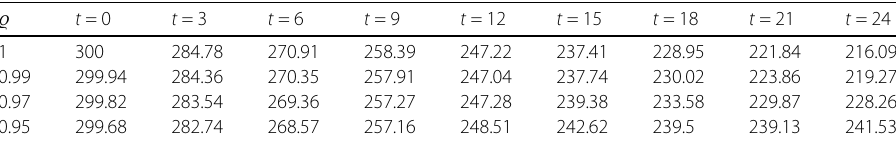
Table 3 Values of R ( t ) for four different orders of CF D (cid:2)